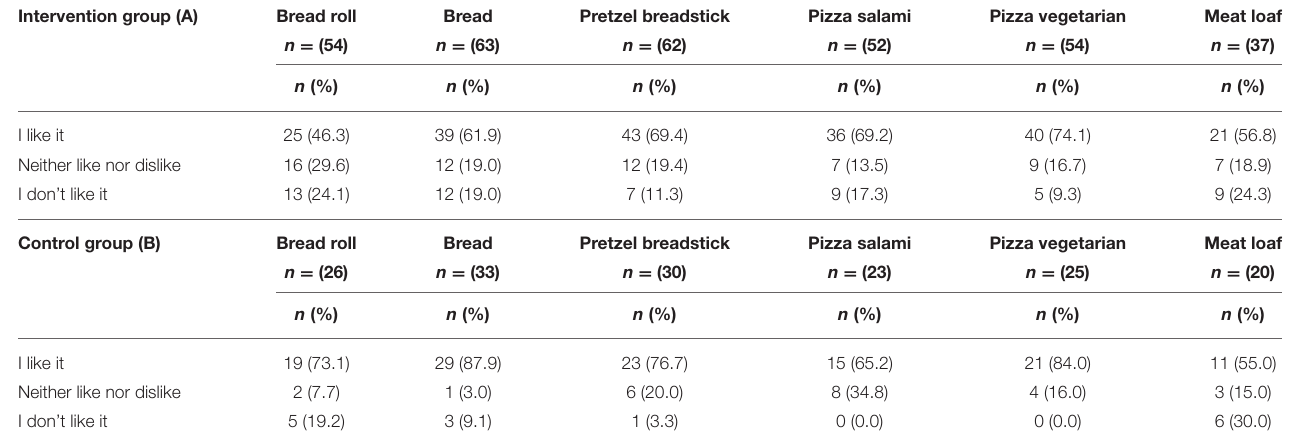
TABLE 5 | Rating of selected study products by participants of the intervention group (A) and participants of the control group (B) . Intervention group (A) Bread roll Bread Pretzel breadstick Pizza salami Pizza